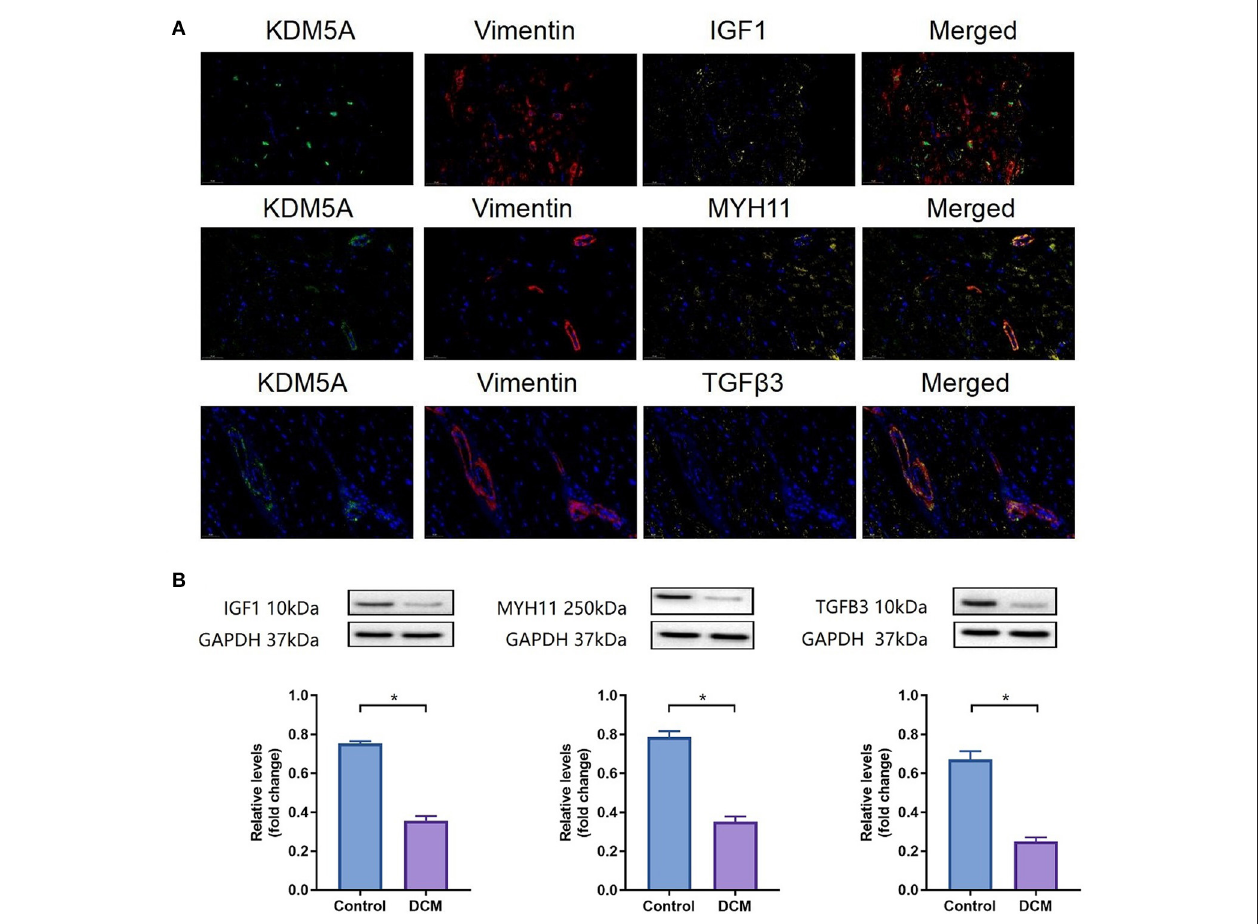
FIGURE 10 | (A) IF staining for KDM5A, Vimentin, IGF1, MYH11, and TGF β 3 in myocardial tissue from DCM patients. DAPI was used for nuclear staining; Alexa Fluor 488 was used to detect KDM5A, Alexa Fluor 594 was used to detect Vimentin, and Alexa Fluor 633 was used to detect IGF1, MYH11, and TGF β 3. (B) Western blotting results of IGF1, MYH11, and TGF β 3 protein expression in DCM patients and controls. Each data point was obtained from three replicate experiments. * P <